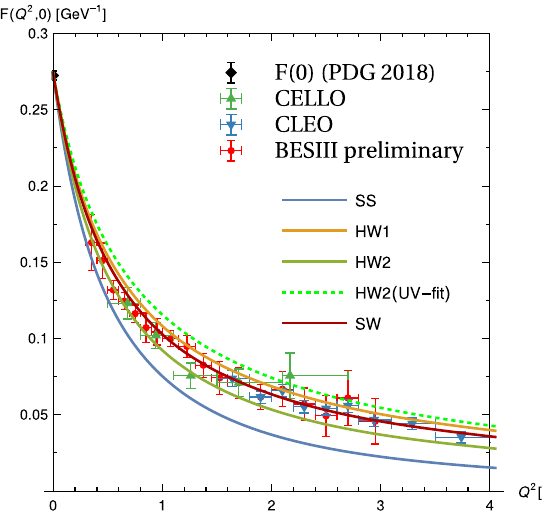
Fig. 7 Data for the π 0 TFF from CELLO, CLEO, BESIII-preliminary as compiled in Fig. 3 of Ref. [30] compared to the results of the various holographic models. The result of the recent dispersion relation study of Ref. [25] (not shown to avoid overcrowding) lies right in between the SW (red) and HW1 (orange) result, with the lower end of the error band given in Ref. [25] nearly coinciding with the SW